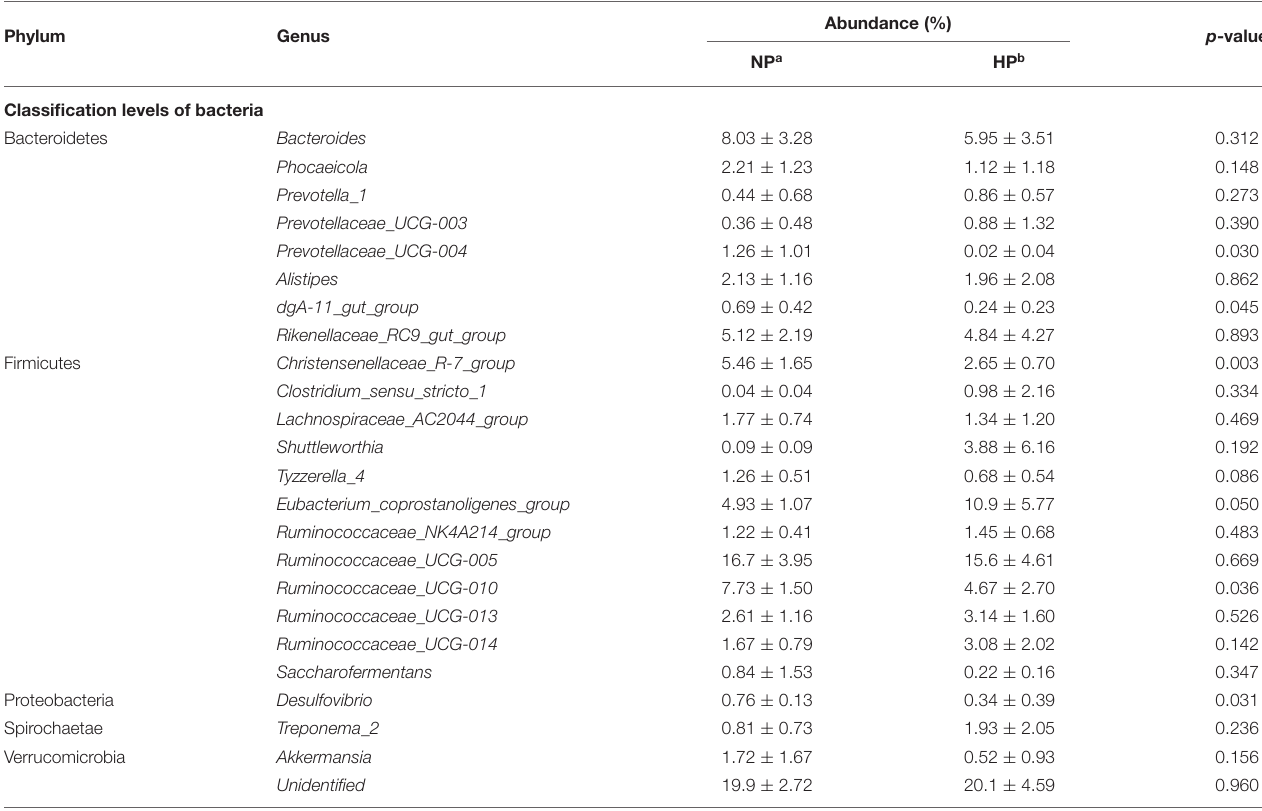
TABLE 1 | Effects of NP and HP diets on the proportion of the cecal bacteria of goats at the genus level (%). Phylum